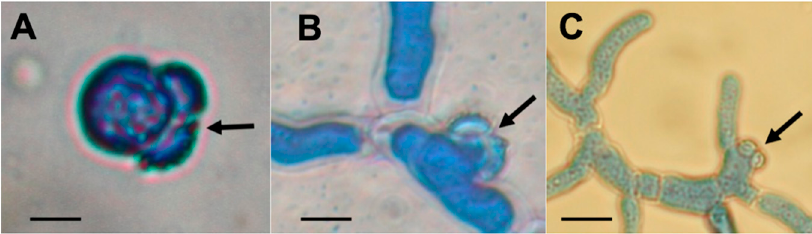
Figure 3. Images of different stages of ascospore germination and emergent colony formation by A. fumigatus following staining with lactophenol cotton blue. Arrows indicate opening of bifurcate ascospores with remnants of outer wall shell visible. Scale bars: ( A ), ( B ) = 5 µm; ( C ) = 10 µm.